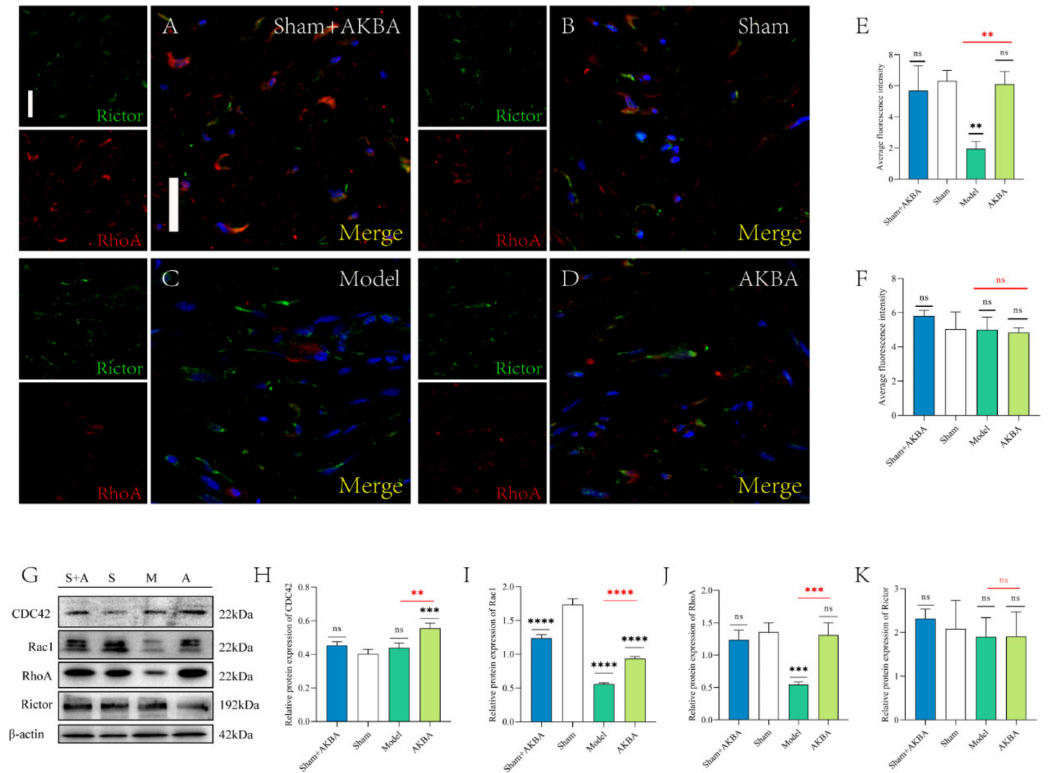
Figure 6. Protein changes in the injured sciatic nerve after 28 d of AKBA intervention. ( A – D ) Immunofluorescence staining plots of RhoA and Rictor for each group. The scale bar is 20 µ m. ( E – F ) Quantification of the mean fluorescence intensity of RhoA and Rictor. ( G ) Immunoblot plots of RhoA, CDC42, Rac1, and Rictor for each group. ( H – K ) Quantification of the protein expres- sion of CDC42, Rac1, RhoA, and Rictor, respectively, in order. Levels were quantified. Black * is the comparison with the Sham group, and red * is the comparison of the Model group with the AKBA group. ** p < 0.01, *** p < 0.001, **** p < 0.0001; ns: no significant